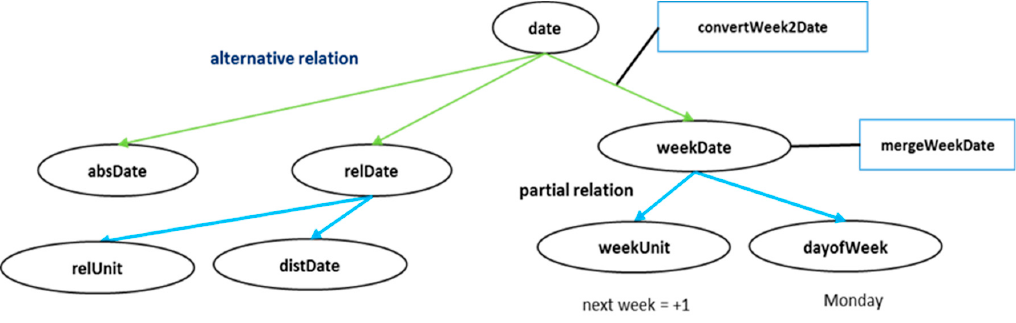
Figure 6. HAS example for date.